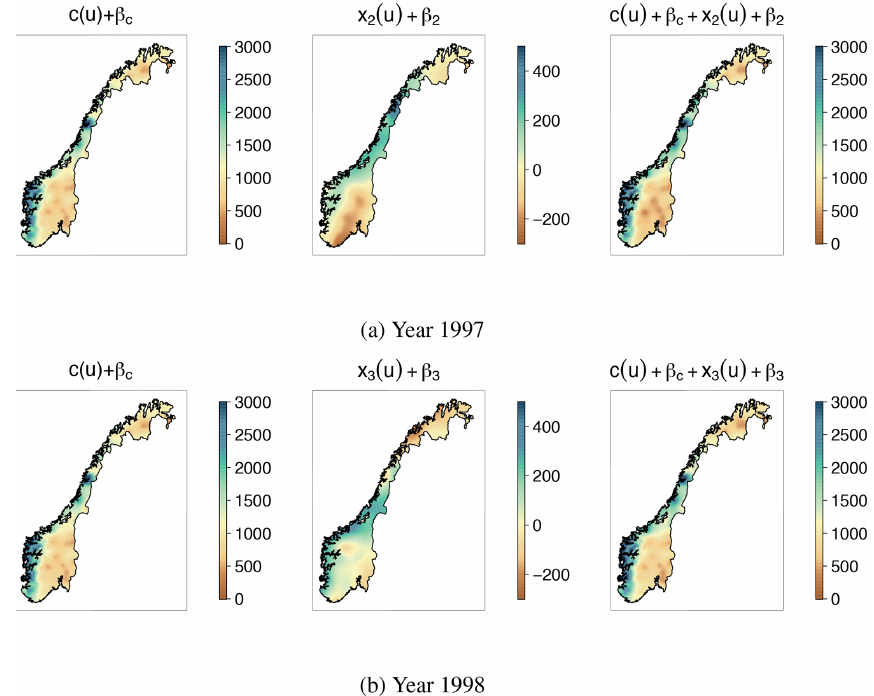
Figure 10. From left to right: the climatic part of the model (common for all years), the annual (year-dependent) part of the model and the full model q j ( u ) for annual runoff in 1997 and 1998 (mmyr − 1 ). Note that the scales of the middle plots only cover 25% of the scale of the other plots. We see that most of the spatial variability of annual runoff for 1997 and 1998 can be explained by climatic effects and that the climatic range ρ c is considerably smaller than the year-specific range ρ x . The results above are produced by the centroid model, and plots similar to these are behind all results presented for the areal and centroid models in this